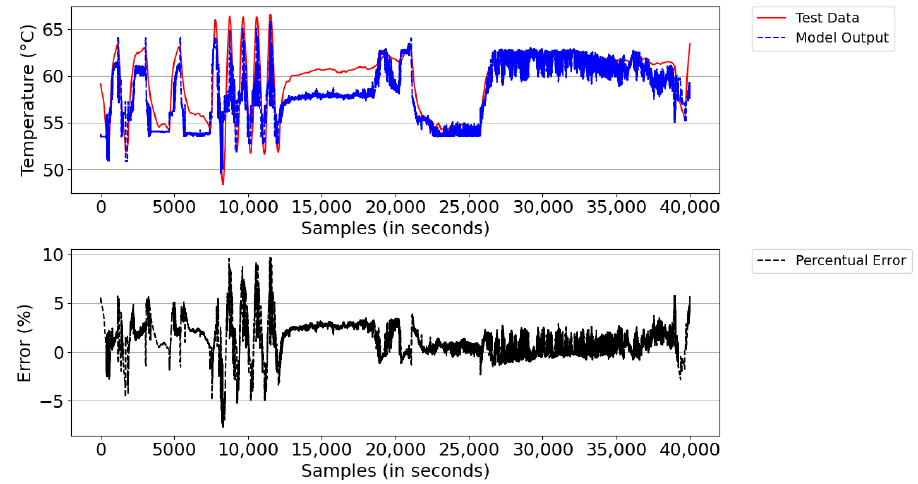
Figure 21. Model result versus actual T out _ HT value and instantaneous percentage